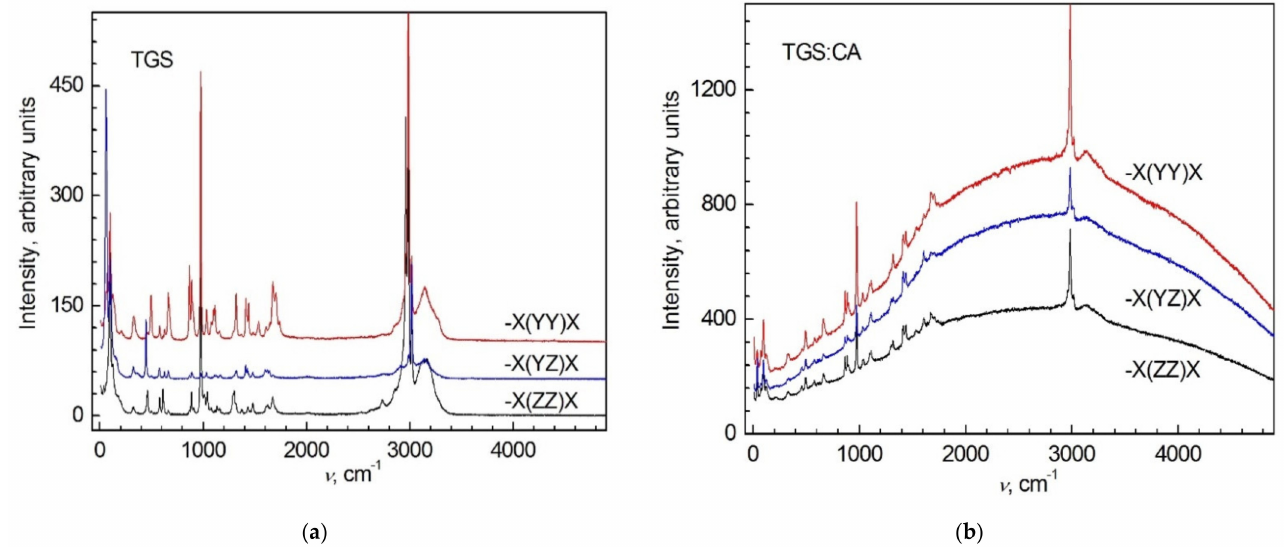
Figure 5. Polarized Raman spectra of ( a ) pure TGS and ( b ) TGS:CA (90:10) single crystals for excitation at λ = 532 nm. For convenience, the spectra for different polarizations are shifted along the vertical